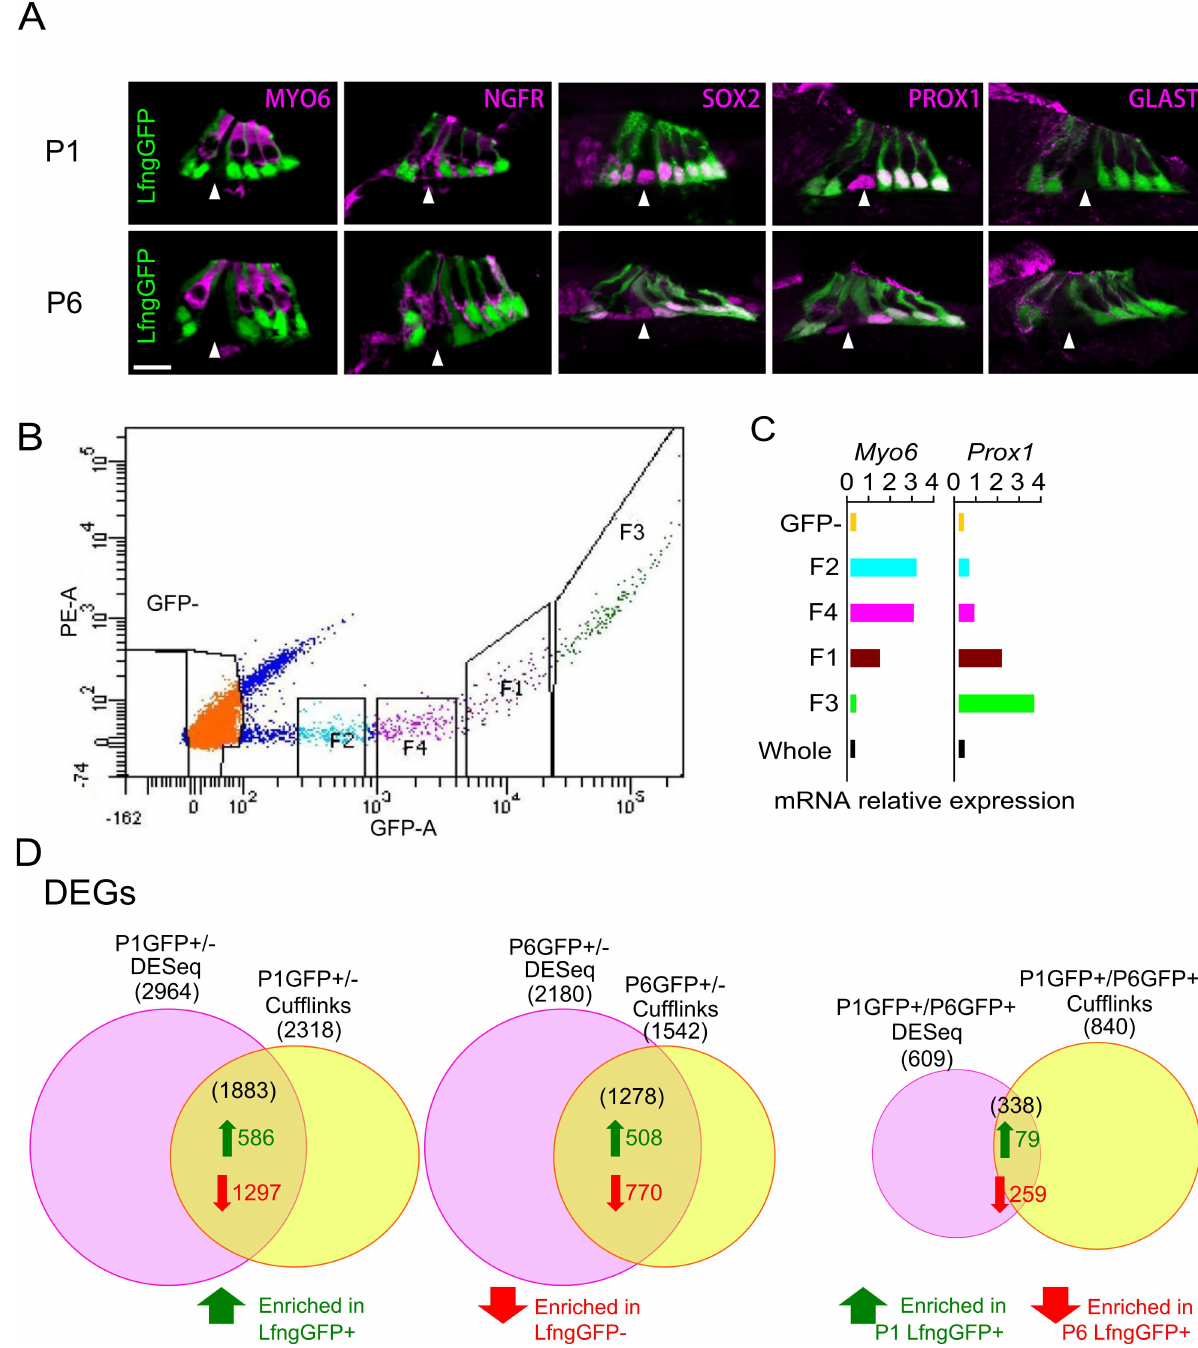
Fig 1. Isolation of neonatal supporting cells and analysis by RNA-seq. (A) Sections through postnatal day 1 and 6 LFng-GFP transgenic mice. At both ages, the GFP transgene is expressedin border cells, inner phalangeal cells, outer pillar cells and all three rows of Deiters’ cells, but not inner pillar cells (arrowheads). Sections are counterstained with antibodiesto MYOSIN VI to show hair cells and SOX2, PROX1, GLAST or NGFR to show distinct types of supportingcells (magenta). Scale bar 20 μ m. (B) Representative FACS profile for sorting of P1 LFng-GFP transgeniccochleas. GFP intensity is shown on the x-axis, with four fractions (F1-F4) identifiedon the sorting profile. (C) QPCR analysisof the different fractions for expressionof a hair cell marker ( Myo6 ) and a supporting cell marker ( Prox1 ). Cells falling in F3, which containedthe highest Prox1 signaland lowest Myo6 signal were used in subsequent experiments. (D) Identification of transcripts enriched in the GFP + fractions at P1 (left) and P6 (center) using the intersection of differential gene expressionbetweenGFP + and GFP - cells analyzedwith DESeq and Cufflinks. 586 consensus GFP + transcripts were identifiedat P1 and 508 at P6. The right